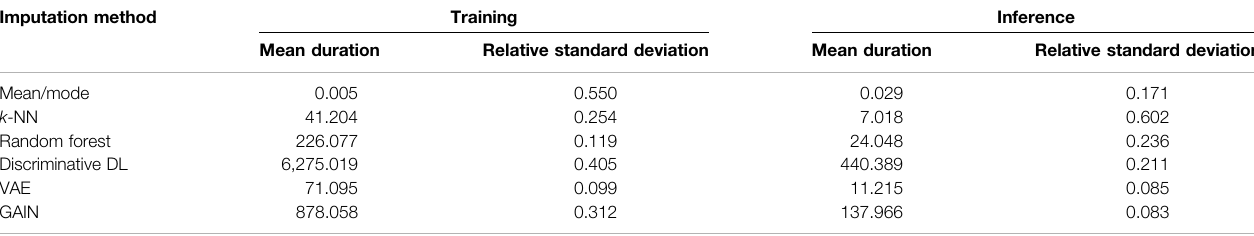
TABLE 7 | Training and inference duration for each imputation method in seconds. We use the wall-clock run time to measure the durations for training, including hyperparameteroptimization and inference for alldatasets withMCAR missingness pattern and all fractions shown in Table 6 .Because trainingand inferencedurations depend heavily on thedataset size, we fi rst calculatethe durations ’ mean and relative standard deviation for each imputation method on every dataset. Second, weaverage those mean durations and relative standard deviations for the imputation methods and present them as Mean duration and Rel. SD separately for Training and Inference